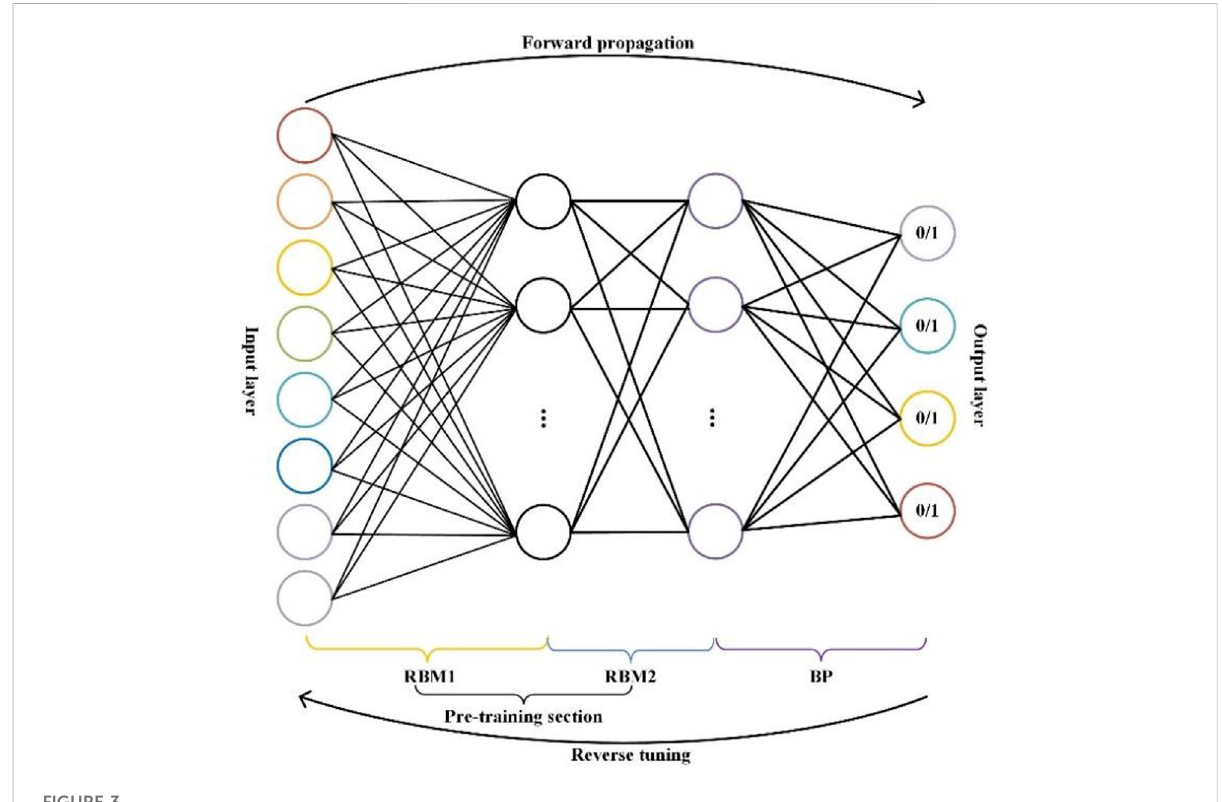
FIGURE 3 Schematic diagram of the DBN